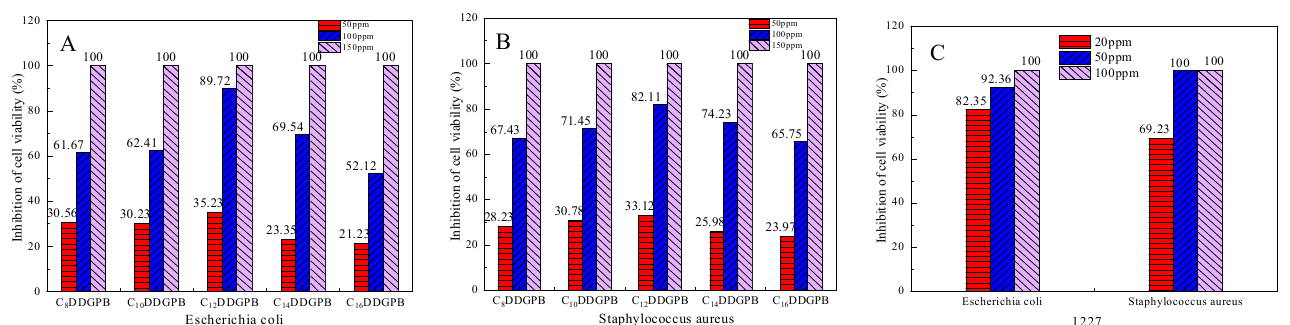
Figure 14. Inhibitory effect of surfactants on bacteria. ( A ) Escherichia coli, ( B ) Staphylococcus aureus, ( C ) 1227.